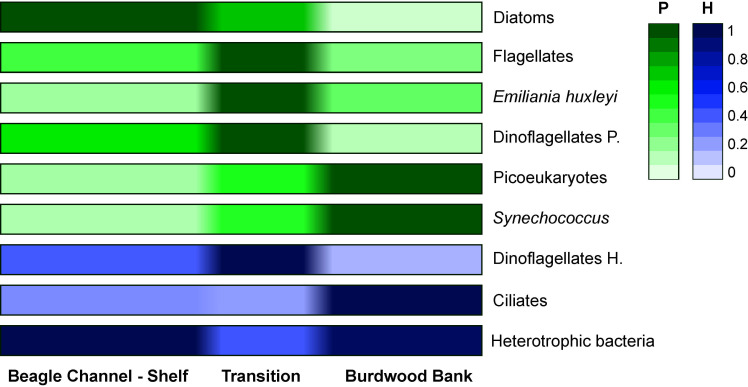
Normalized averaged densities (cells L-1) of the microbial plankton groups in the three areas depicted with the cluster analysis.The BC-shelf area includes stations 1 to 10, the transition zone includes stations 11 to 16, and the BB encompasses stations 18 to 29. Green and blue colors correspond to phototrophic and heterotrophic modes, respectively.